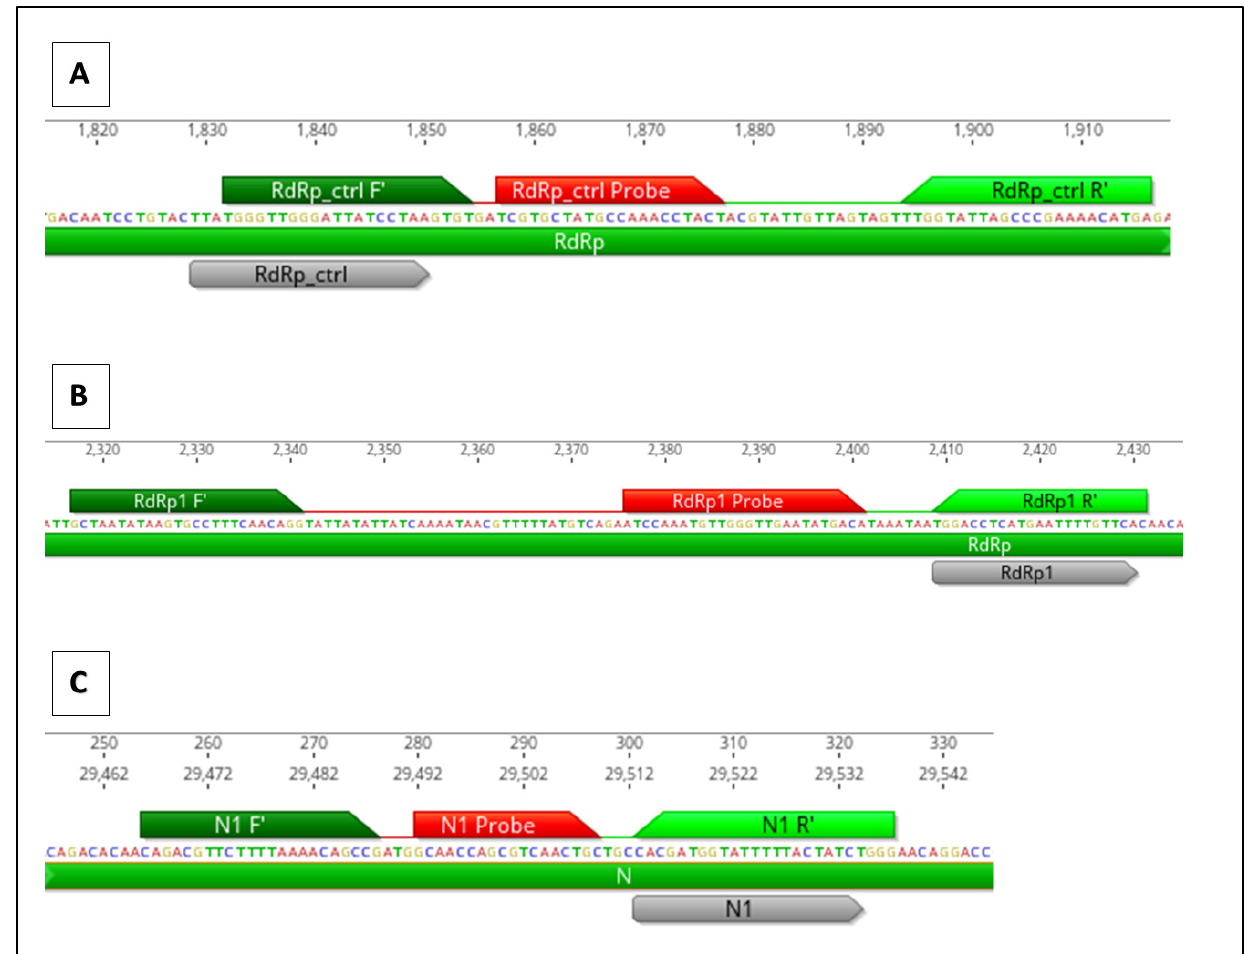
Figure 3. Genomic location of HCoV-OC43 CRISPR gene targets and RT-qPCR assays. CRISPR target sequence is in grey. RT-qPCR forward primers are in dark green, reverse primers are in light green, and probes are in red. ( A ) RdRp_ctrl CRISPR target, ( B ) RdRp CRISPR target, and ( C ) N CRISPR target.